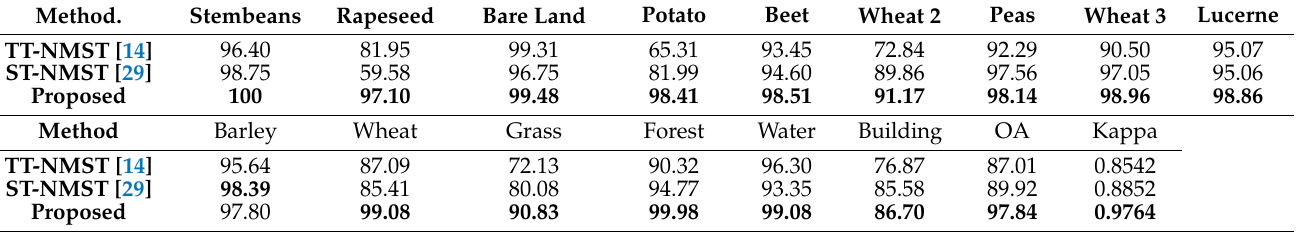
Table 2. Accuracy and Kappa coefficients of dataset 1 for three semi-supervised methods under the condition of 10 LSPCs.